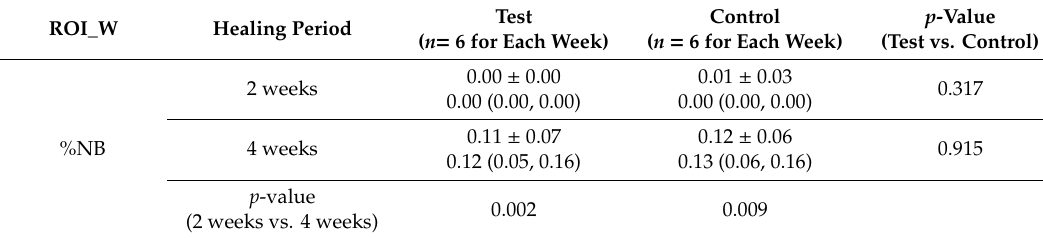
Table A2. Percentage of newly formed bone and residual bone substitute material in the regions of interest (ROIs = 0.64 mm 2